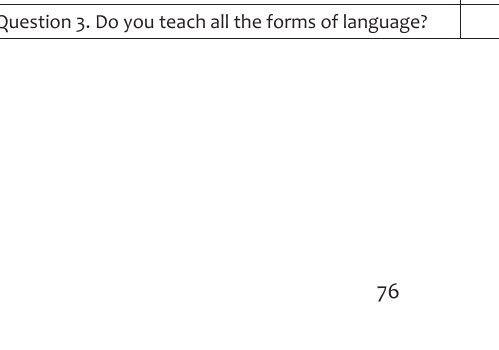
Table 6: Teaching of language forms Question 3. Do you teach all the forms of